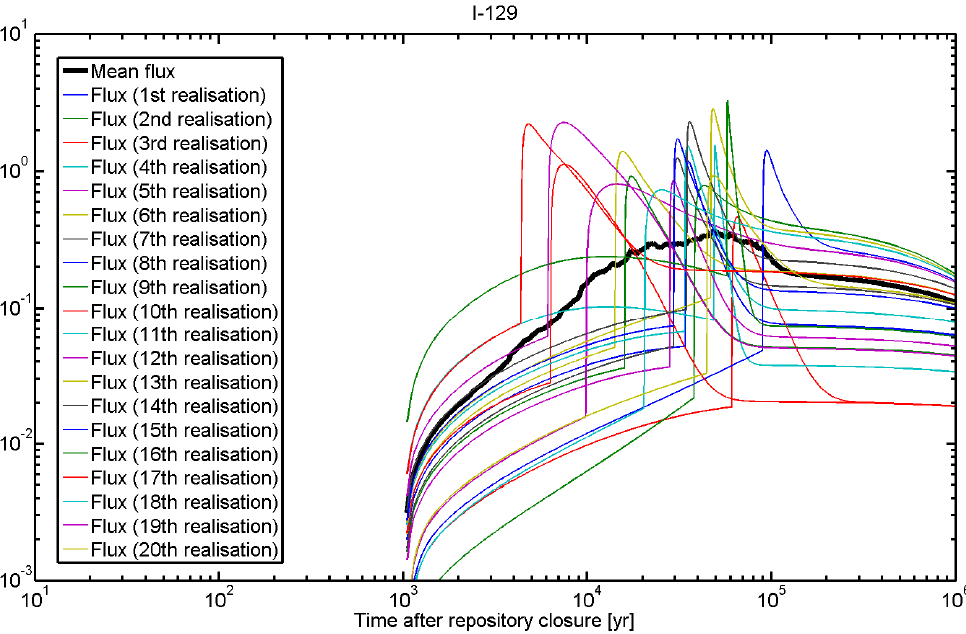
Figure 2. The flux of I-129 flux from the engineered barriers (results of the first 20 realizations and the mean flux) from